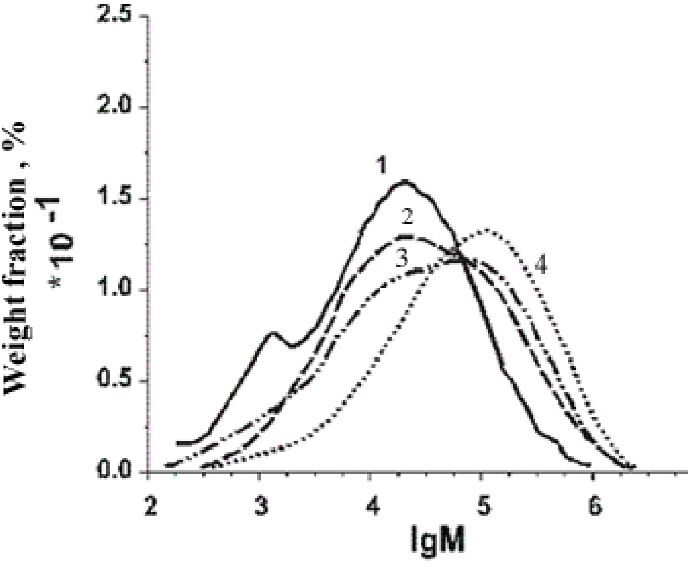
Fig. 2 The molecular weight distribution curves of PP at the di¬erent times of mechanochemical action in the modi› cation